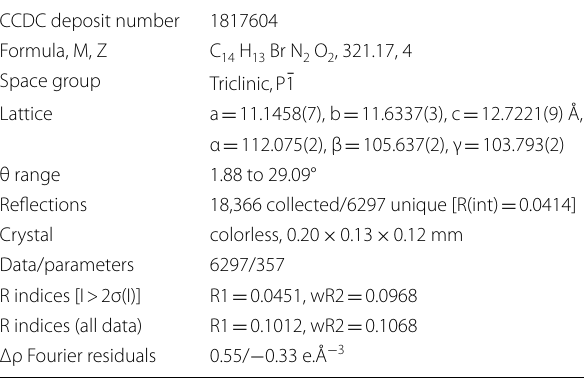
Table 2 Atomic coordinates ( is defined as 1/3 of the trace of the orthogonalized U